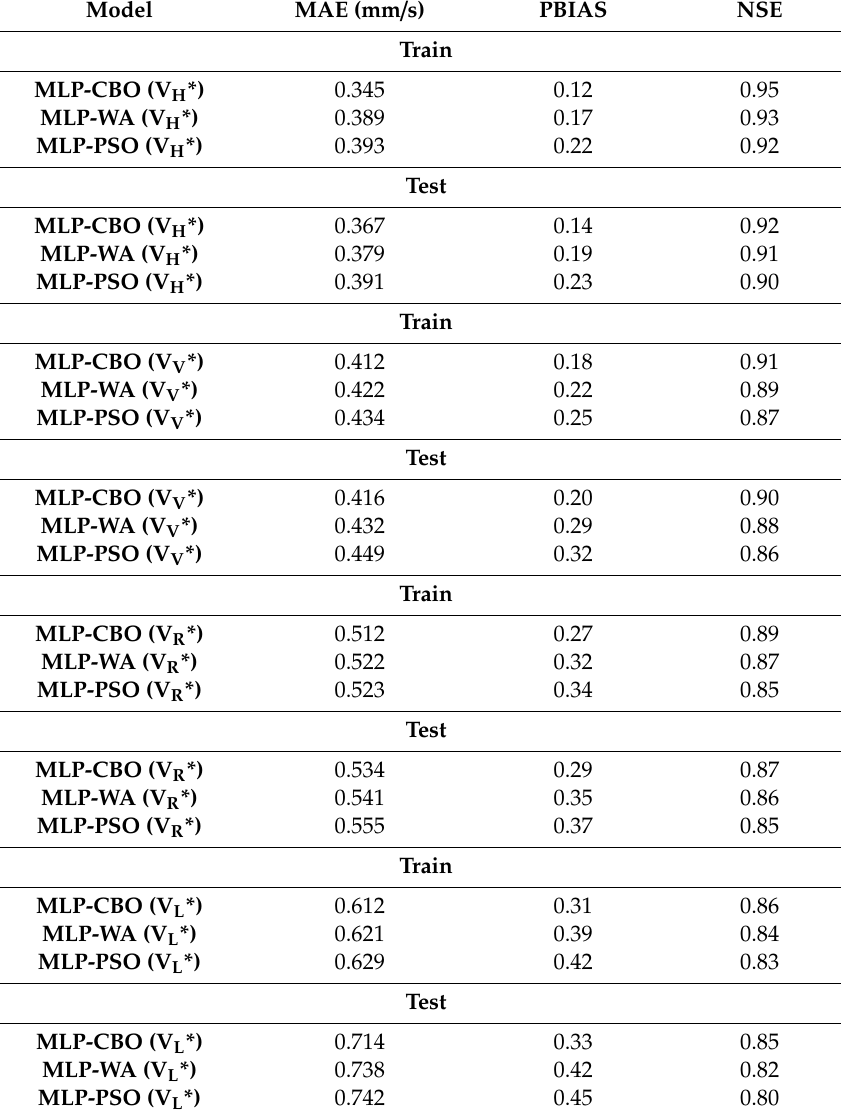
Table 3. The statistical results for soft computing models. MAE: mean absolute error; PBIAS: percent bias; NSE: Nash–Sutcli ff e ffi ciency; MLP: multilayer